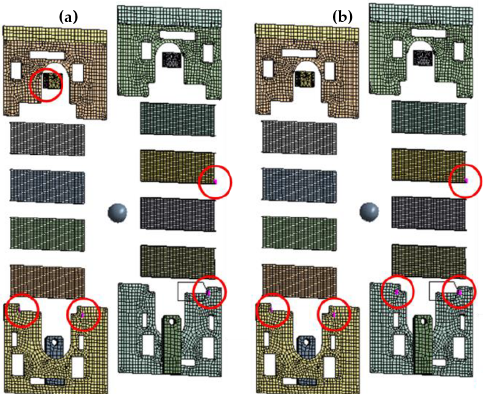
Figure 4. The optimal sensor placement result: ( a ) Pearson–Fisher Information Matrix, ( b ) Pearson Effective